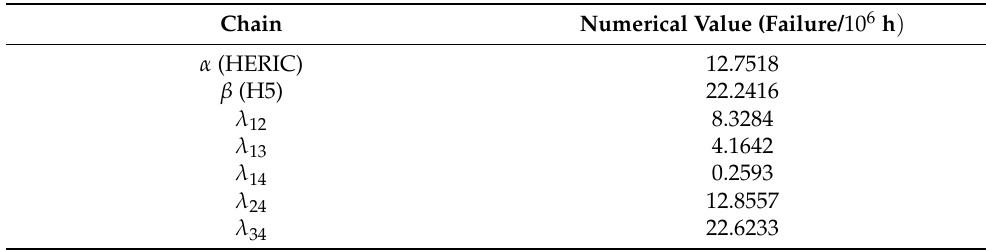
Table 8. Numerical Values for the Transition Rates in Markov Chain Models of HERIC, H5,